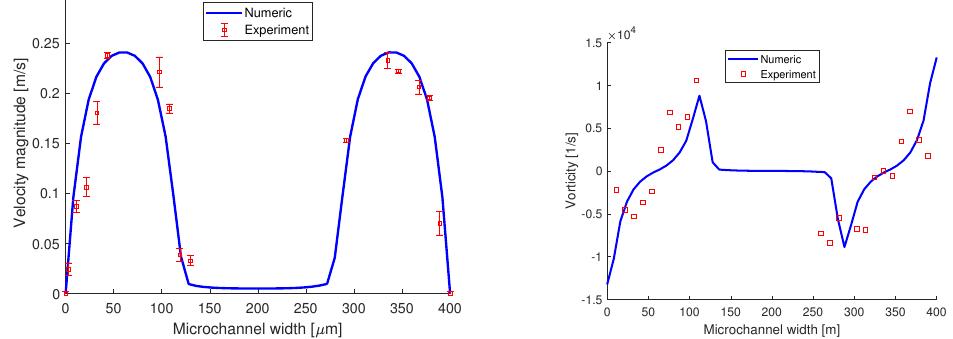
Figure 17. Quantitative validation of the numerical simulation using velocity and vorticity distribu- tions, obtained from the micro-PIV measurements, as can be seen in Figure